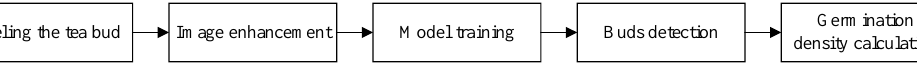
Figure 1. Research general framework.